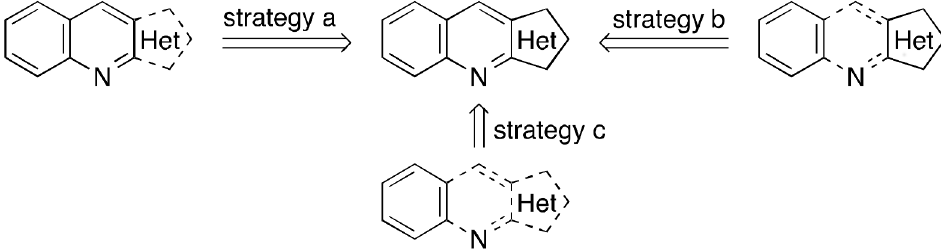
Figure 1. Synthetic strategies for the construction of the heteroaryl[ b ]quinoline (HA[ b ]Q) structure.